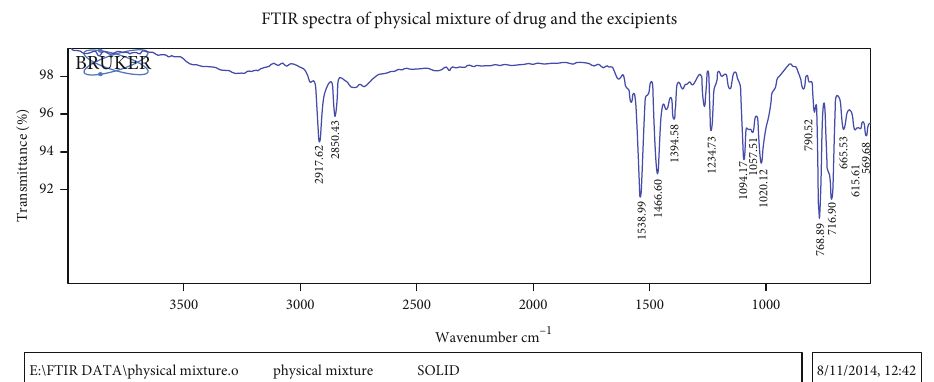
Figure 1: FTIR spectra of drug and